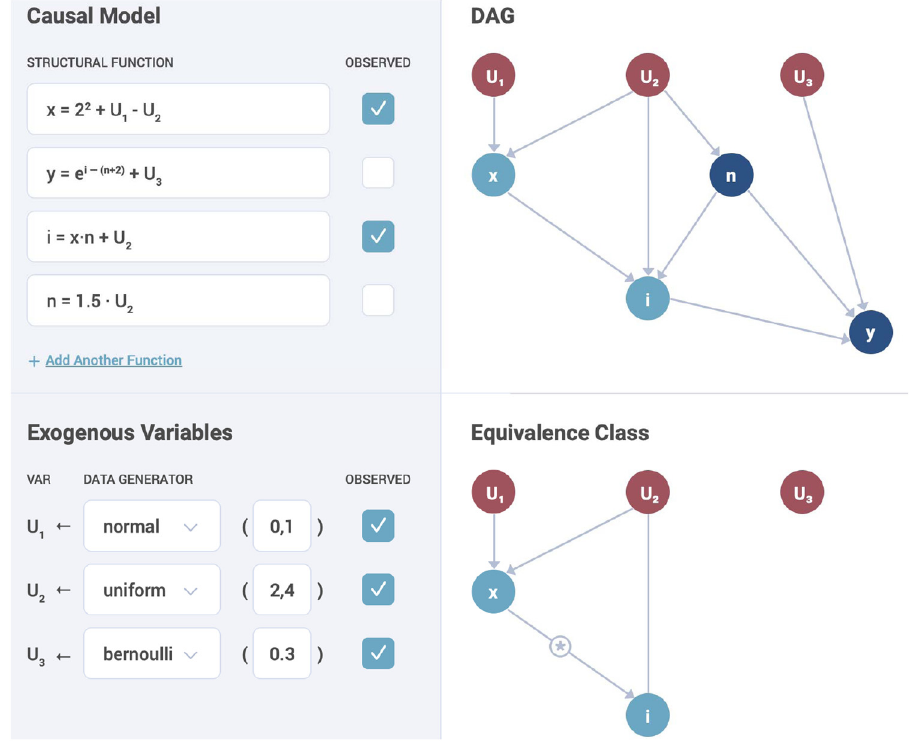
Figure 4: Causal discovery exercise